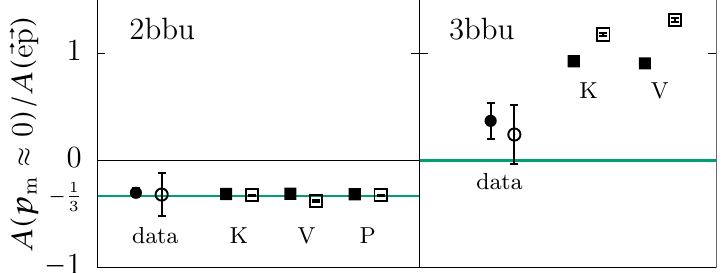
Figure 3: The A ( 67 ◦ ,0 ◦ ) (full symbols) and A ( 156 ◦ ,0 ◦ ) (empty symbols) asymmetries for 2bbu (left) and 3bbu (right) divided by the corresponding asymmetries for elastic (cid:126) e (cid:126) p scattering at the same value of Q 2